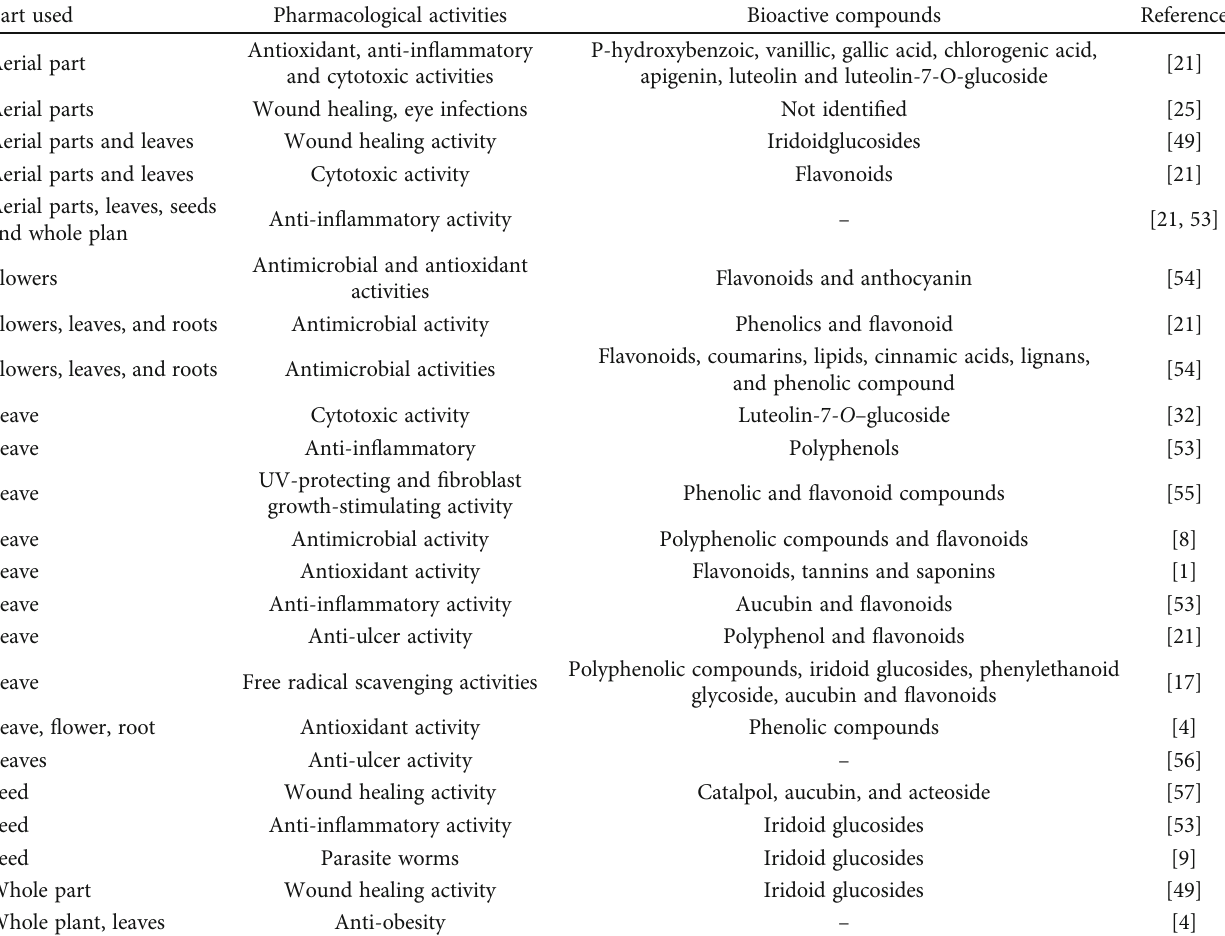
Table 4: Pharmacological activities of di ff erent parts of P. lanceolata